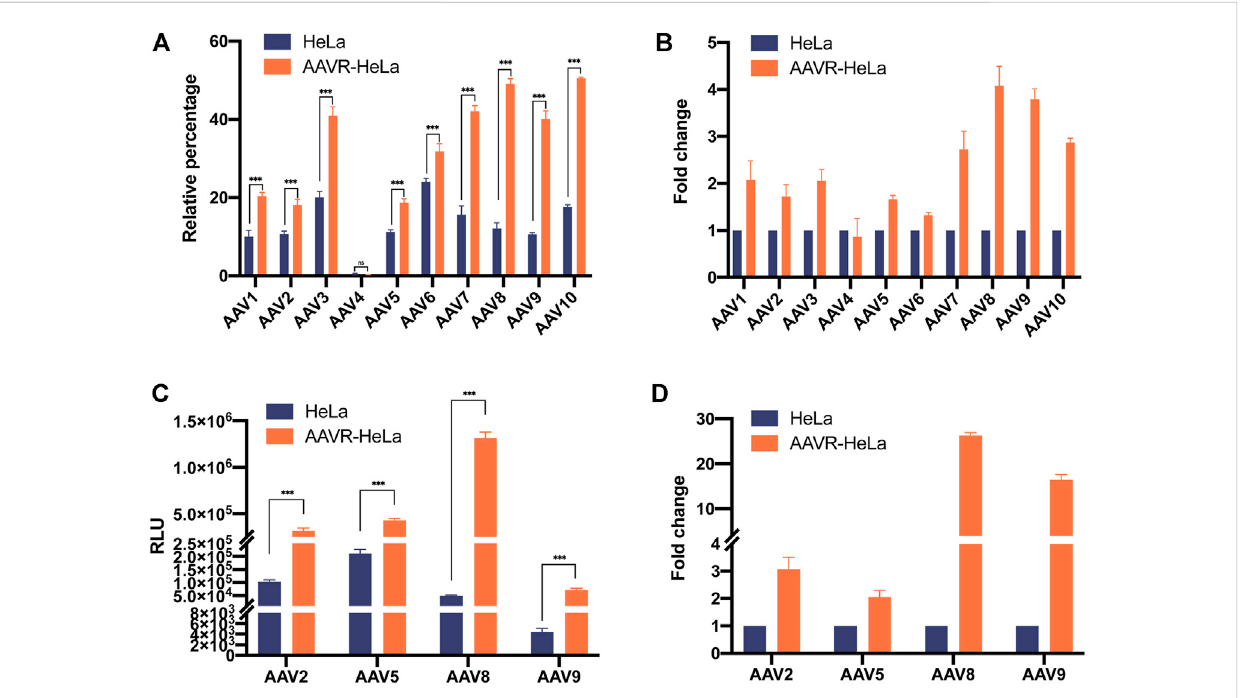
FIGURE 2 Enhancedtransductionef fi ciencyforrAAV-EGFPandrAAV-LucvectorswithdifferentserotypesinAAVR-HeLacells.TherAAVvectorswithdifferent serotypescarryingEGFPorluciferasewereusedtoinfectAAVR-HeLacells.Theresultswerepresentedasmean±SD( n =3)andanalyzedusingGraphPad Prism version 8.4.0 (* p < 0.05, ** p < 0.01, *** p < 0.001). (A) Transduction ef fi ciencies of rAAV vectors (AAV1-10) carrying EGFP in HeLa and AAVR-HeLa cells. (B) ThefoldchangesofrAAVvectors(rAAV1-10)carryingEGFPinAAVR-HeLacellscomparedtoHeLacells. (C) Transductionef fi cienciesofthe rAAV-Luc in the serotypes of AAV2, AAV5, AAV8, and AAV9 in HeLa and AAVR-HeLa cells. (D) The fold changes of rAAV-Luc in the serotypes of AAV2, AAV5, AAV8, and AAV9 in AAVR-HeLa cells compared to HeLa